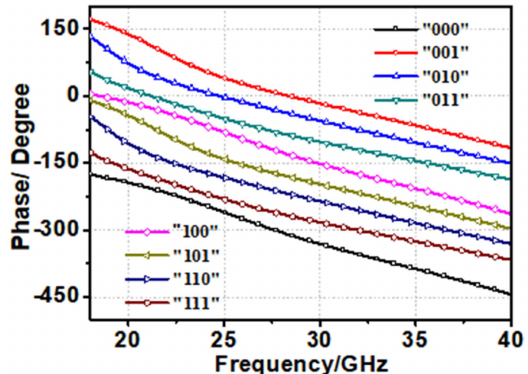
Figure 7. Phase of cross-polarized reflection for eight basic